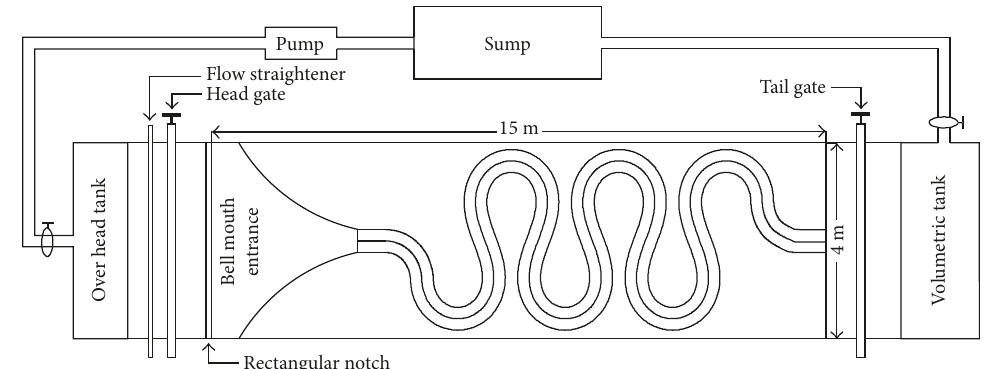
Figure 1: Planform of the experimental setup for the the meandering channel.